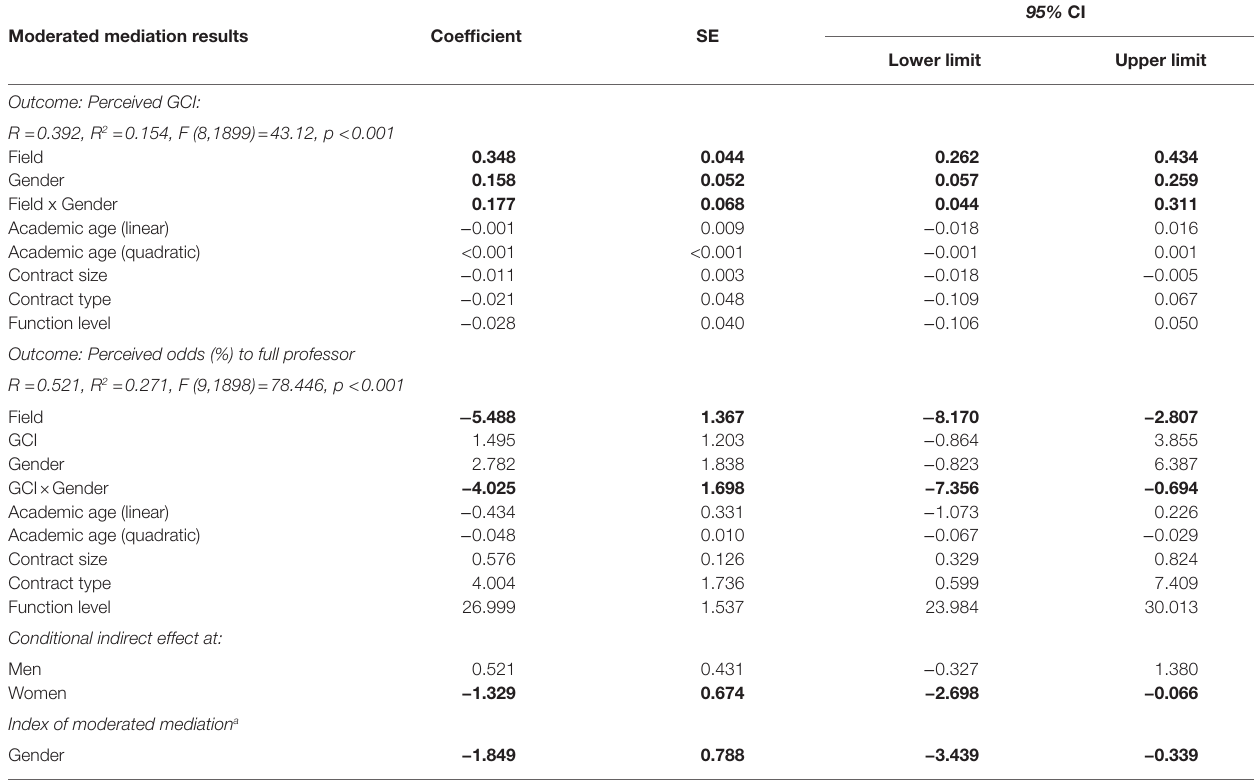
TABLE 3 | Moderated mediation results link between field, gender, perceived GCI and perceived odds to become full professor ( N =